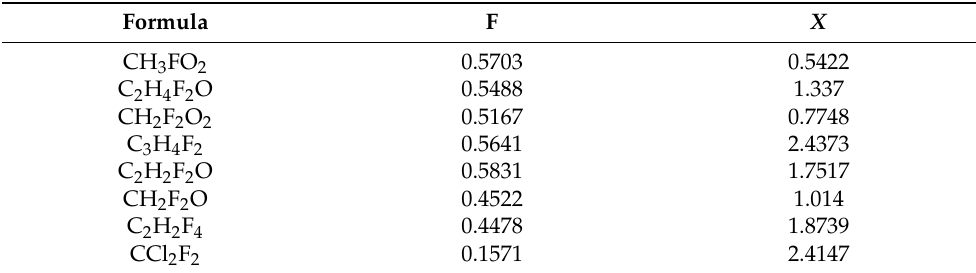
Table 3. Flammability and toxicity values for new